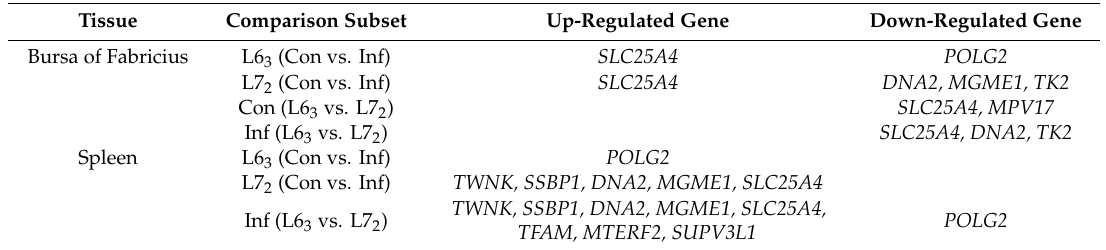
Table2. DysregulatednucleargenesinvolvedinthemtDNAreplication, transcription, andmaintenance. Tissue Comparison